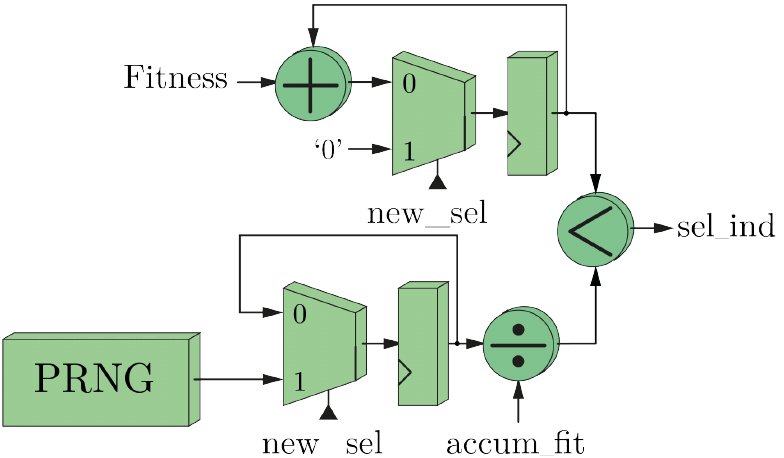
Figure 7. Block diagram for roulette-wheel-based selection